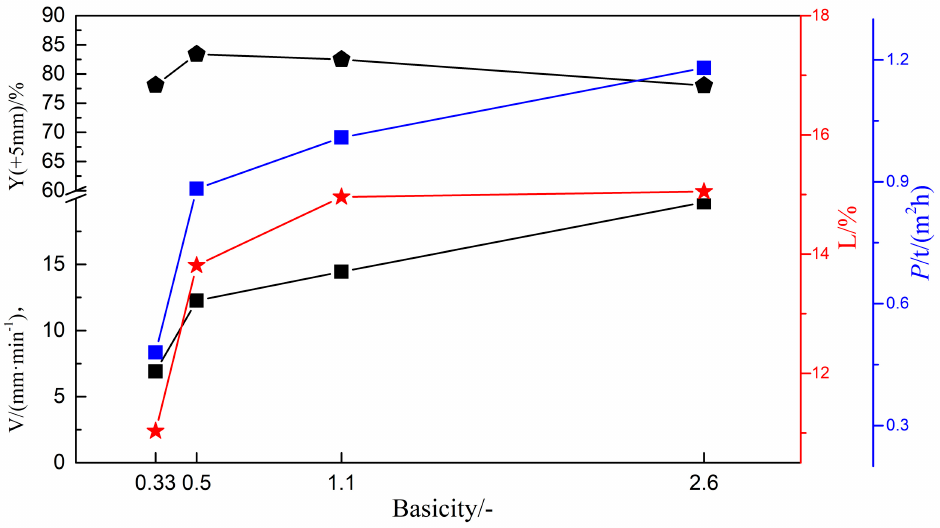
Figure 2. Sintering process parameters of acid, self-fluxing, and high-basicity PVTM sinters.